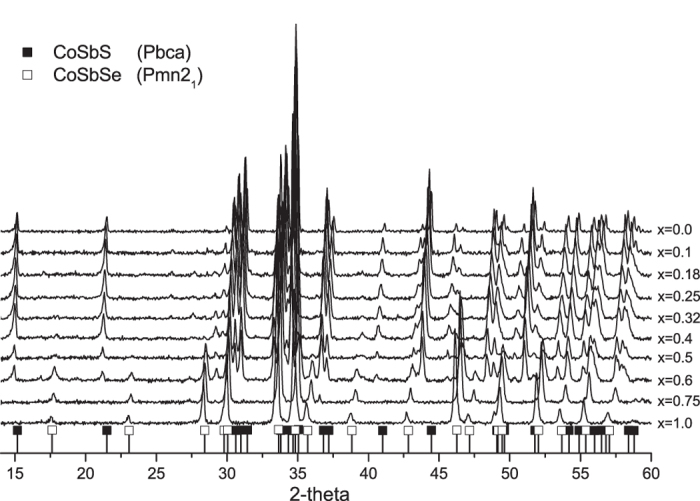
X-ray diffractions patterns collected at room temperature on CoSbS1−xSex alloys.X is varying from 0 to 1. Only peaks with relative intensity above 10% are shown.